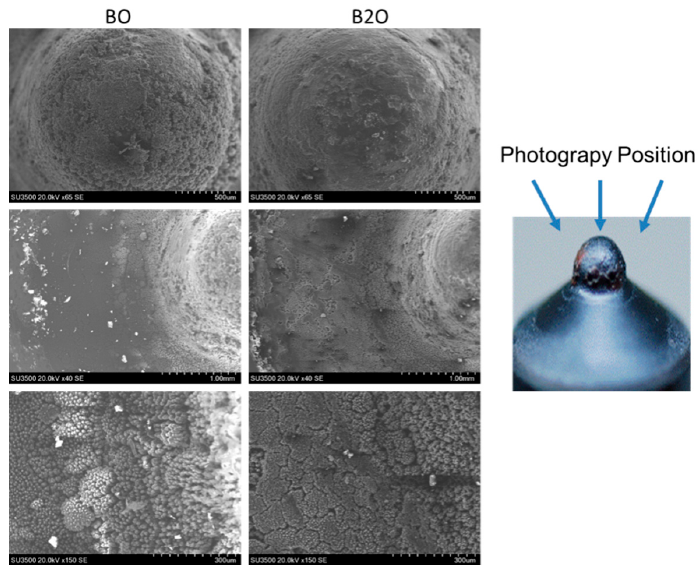
Figure 8. Injector tip deposits for B0 and B20. Energies 2020 , 13 , x FOR PEER REVIEW